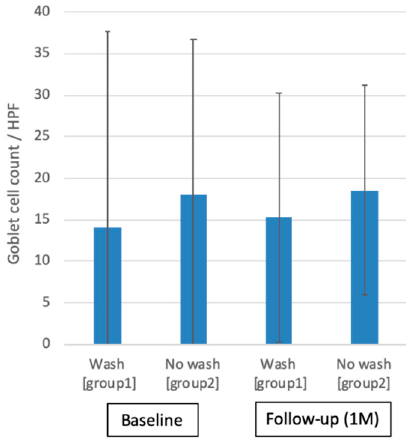
Figure 7. Goblet cell count in periodic acid Schiff (PAS) staining. Note the nonsignificant changes in goblet cell count between before and after 1 month of eyewash use ( p > 0.05).